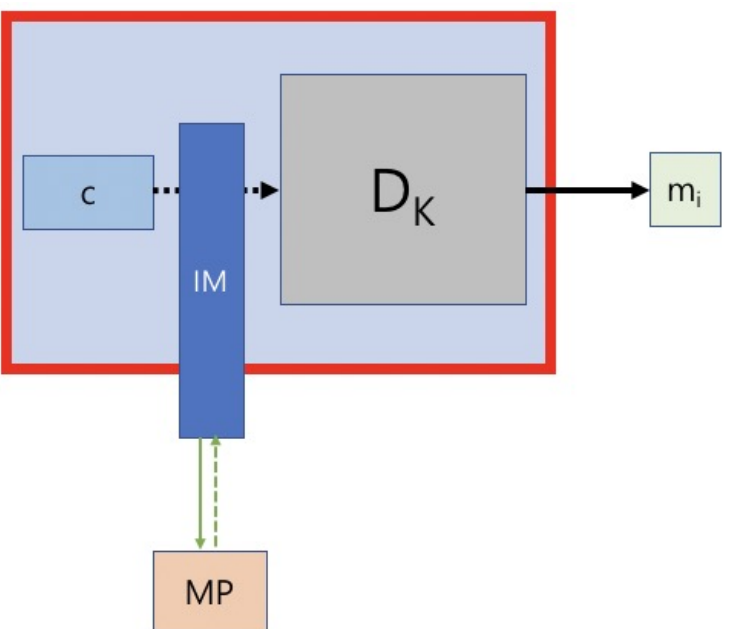
Figure 1. The structure of SPDC s , where c is the decrypted content (1), IM is the immobilizer, D K is the key hidden decryption function (2), and m i is a decrypted bitstream by D K